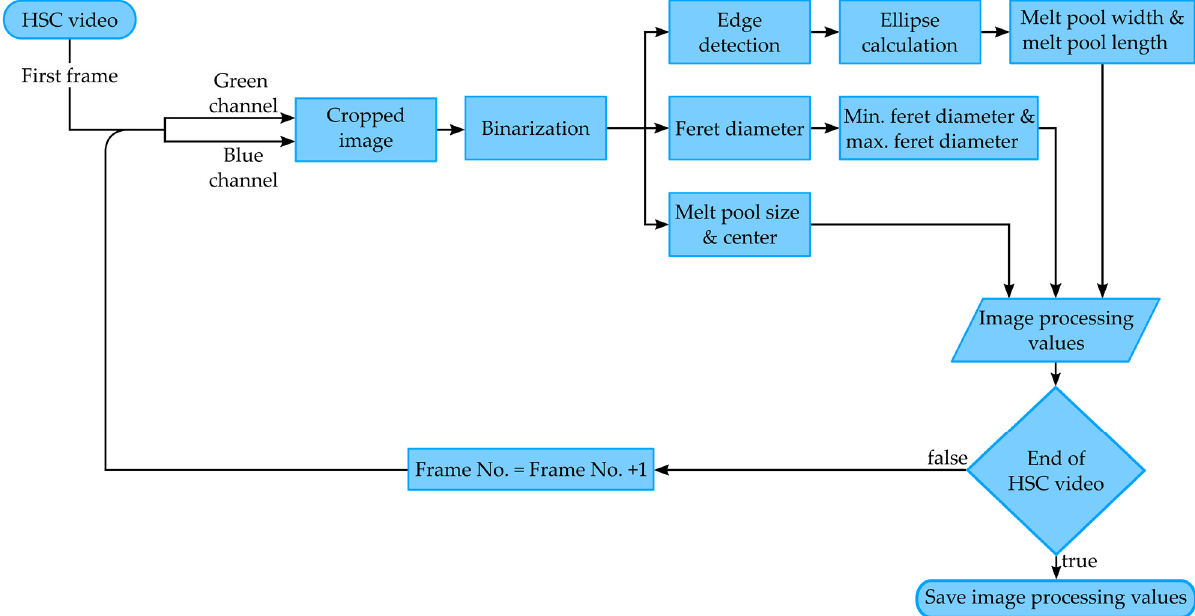
Figure 3. Flowchart of the image evaluation to determine spectral and geometric information from the melt the melt pool.